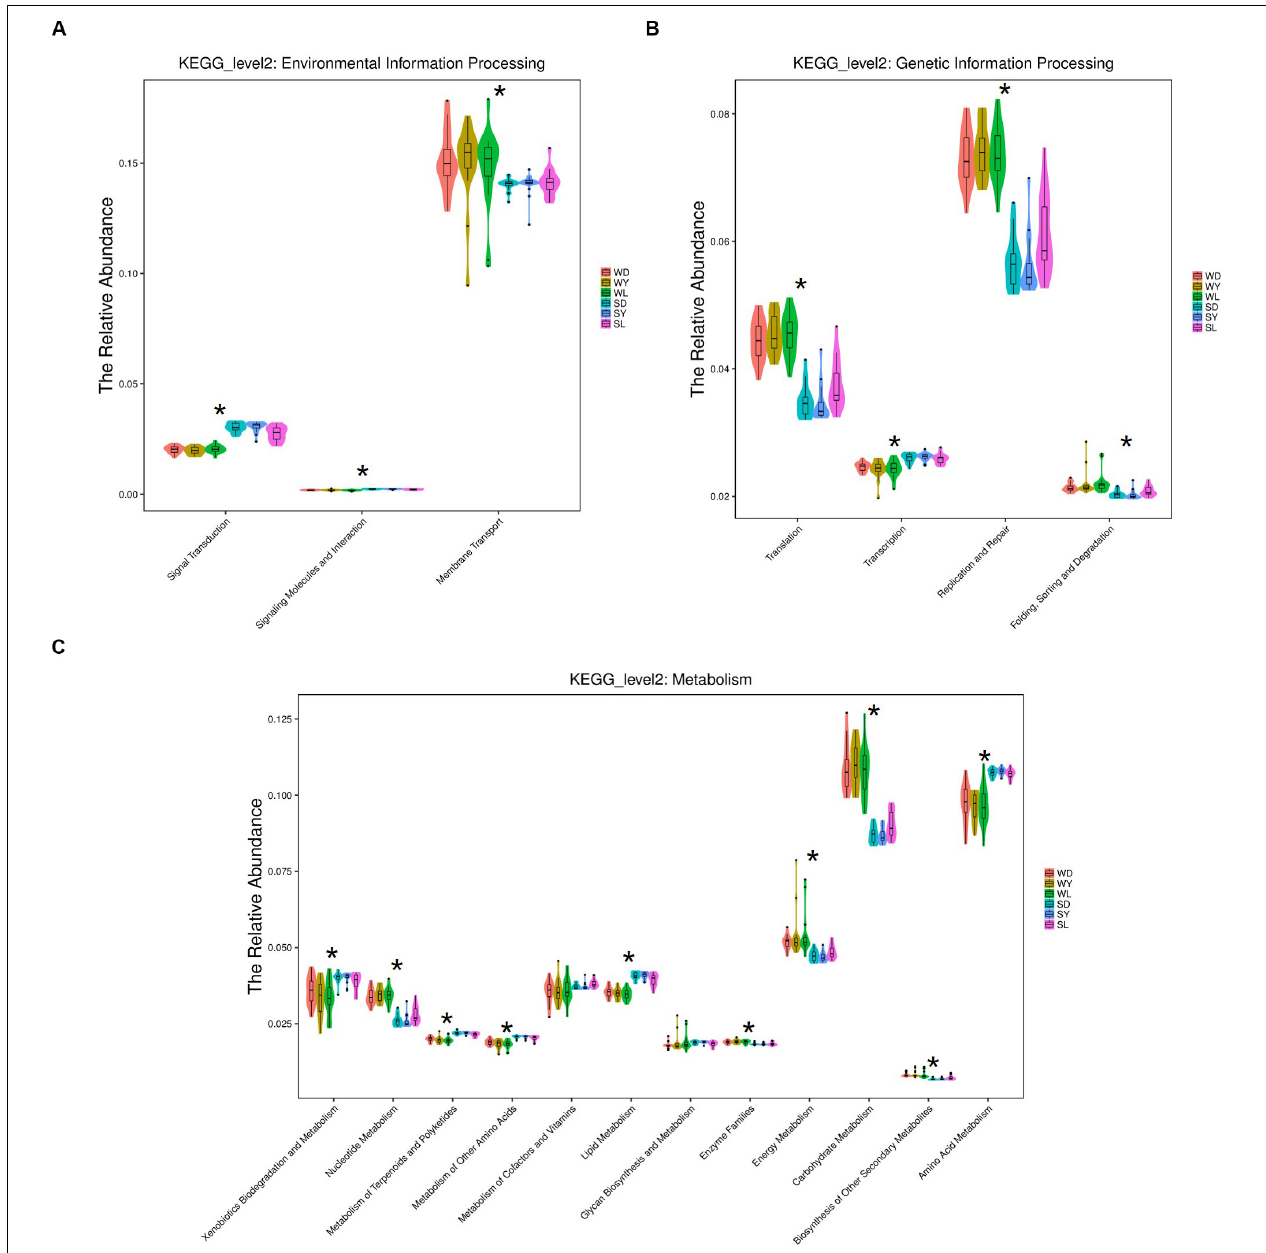
FIGURE 5 | KEGG analysis and function prediction of semen bacteria in winter and summer. (A) Environmental information processing pathway, (B) genetic information processing pathway, and (C) metabolism pathway. WD, samples collected from Duroc in winter; WY, samples collected from Yorkshire in winter; WL, samples collected from Landrace in winter; SD, samples collected from Duroc in summer; SY, samples collected from Yorkshire in summer; SL, samples collected from Landrace in summer. The * means significant differences ( P < 0.05) between summer and winter semen in all breeds of boars, and P -value was corrected for multiple testing according to the procedure of